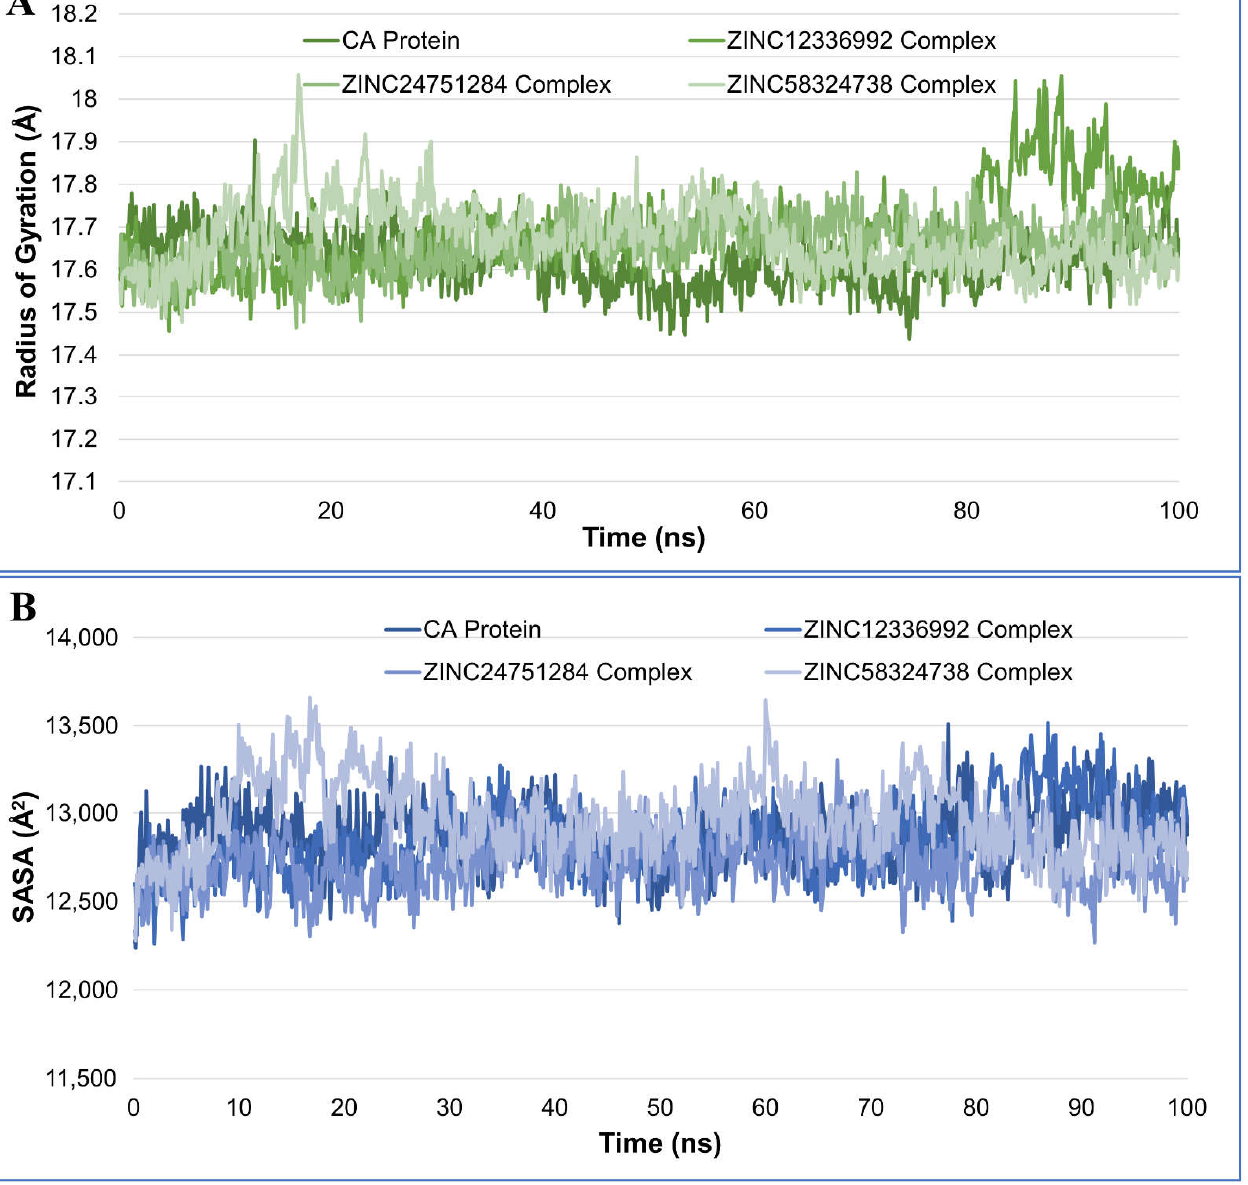
Figure 6. Plot of the radius of gyration ( A ) and solvent-accessible surface area (SASA) ( B ), during the 100-ns molecular dynamics simulation of the carbonic anhydrase protein and complex of ZINC12336992, ZINC24751284, and ZINC58324738.